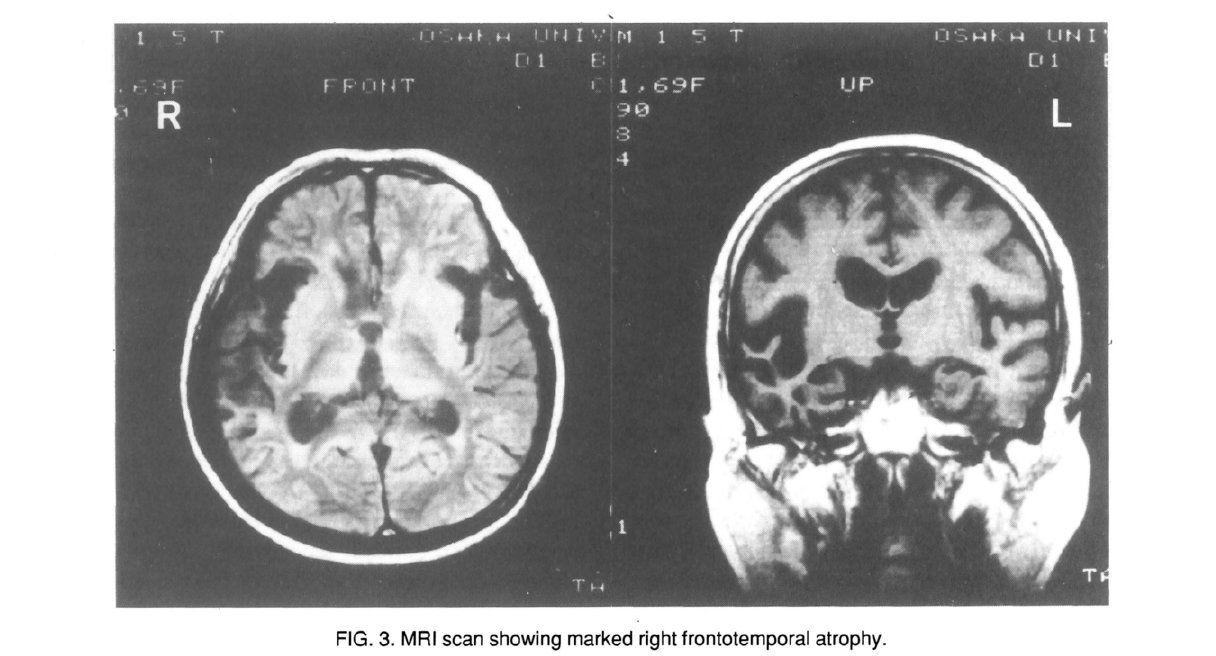
FIG. 3. MRI scan showing marked right frontotemporal